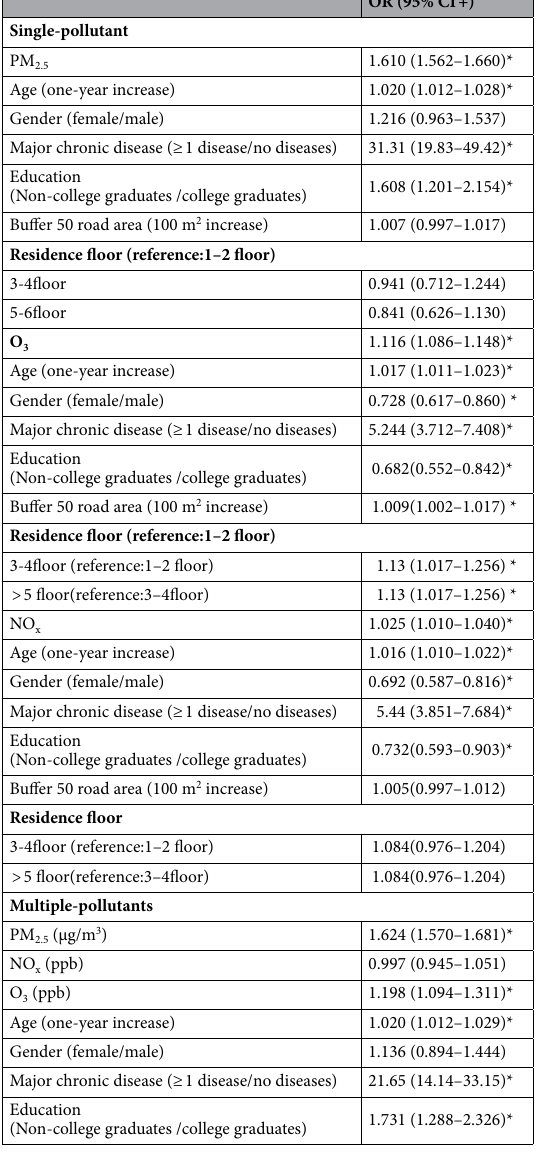
Table 2. Adjusted odds ratios of insomnia for single pollutant and multiple pollutants by multiple logistic regression models for 5108 study subjects in Taipei City Hospital (N = 5108). *OR: odds ratio. + CI: confidence interval. *Statistically significant, p < 0.05. Single-pollutant: adjusted for age, gender, major chronic diseases, educational level, buffer 50 road area, and residence floor. Multiple-pollutants: adjusted for age, gender, major chronic diseases, educational